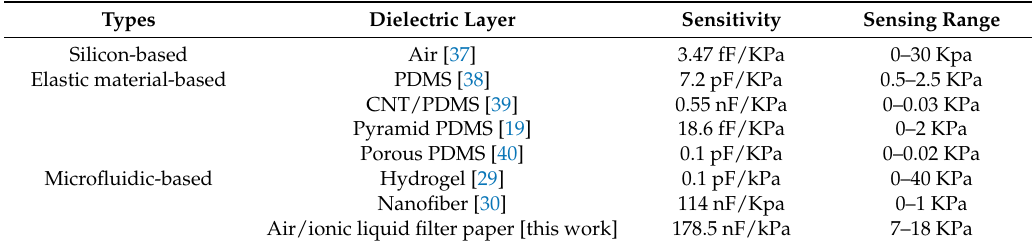
Table 1. Comparison of the sensitivity of capacitive pressure